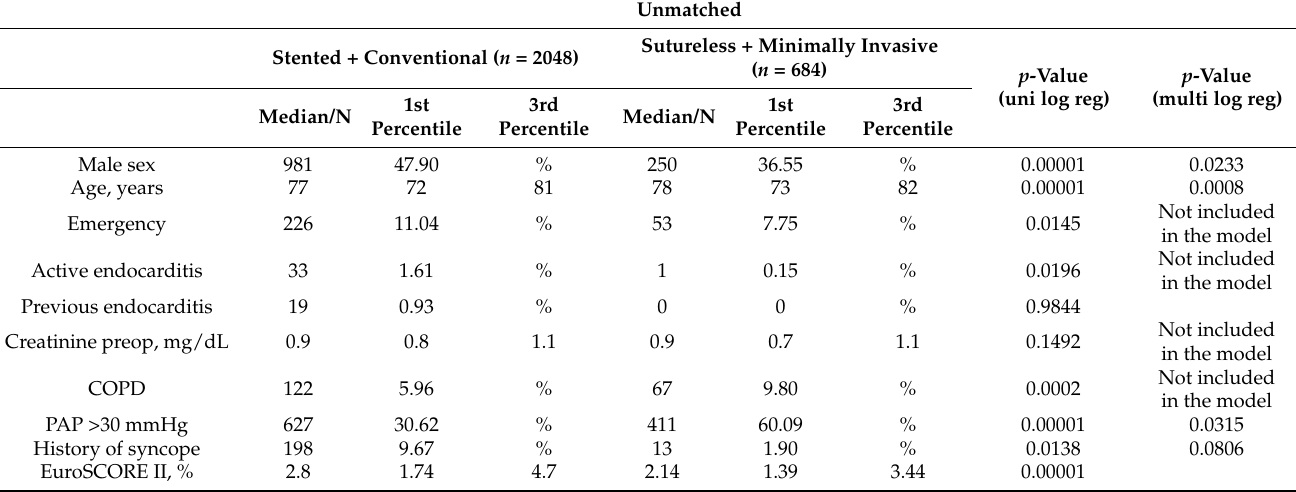
Table 1. Preoperative characteristics of the study population before and after propensity score